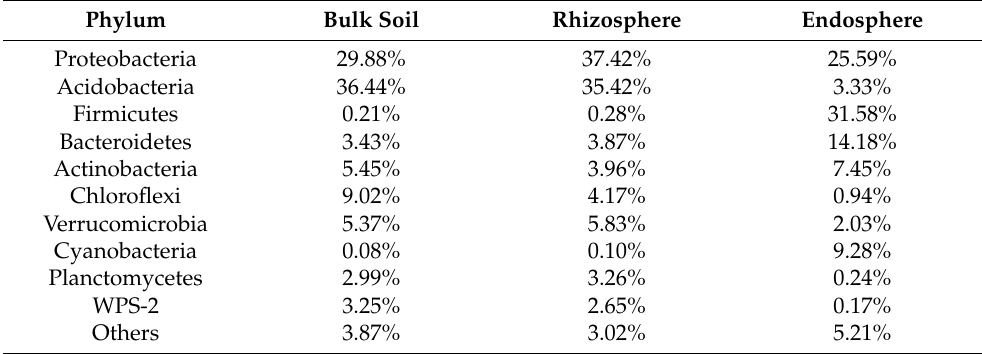
Figure 3. Relative abundance of bacteria at phylum ( a ) and class levels ( b ) based on all samples in each sample type. Table 1. Mean relative abundances of top 10 differential phyla (%) in different sample